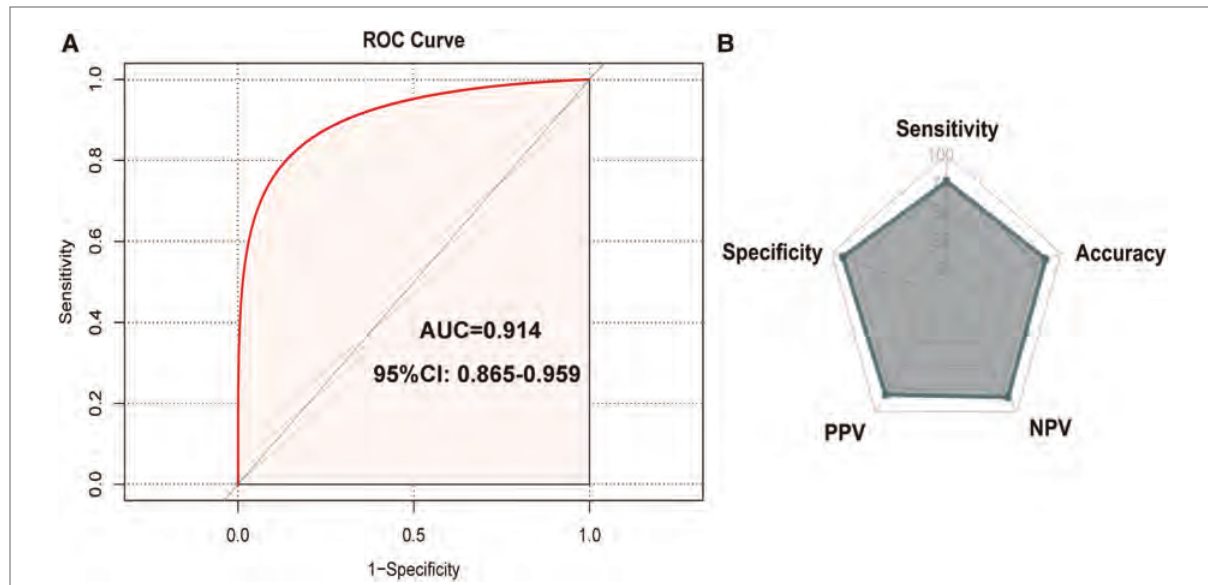
FIGURE 7 Receiver operating curve (ROC) that showed performance of predicting model. Note: the cut-off level of >69.0 nomogram predicted immediate urinary continence recovery (sensitivity=76.6%, speci fi city=87.8%, positive predictive value=81.7%, negative predictive value=84.0%, accuracy =83.1%), and an area under curve (AUC) of 0.914 (95% CI: 0.865-0.959, p <0.001). AUC, area under the